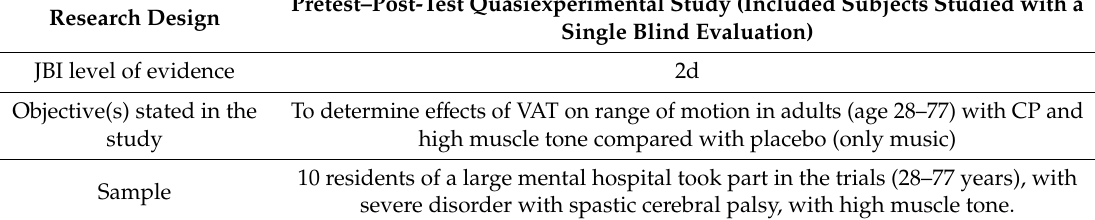
Table 8. Studies on adults with CP—Wigram, chapter 4 [35].